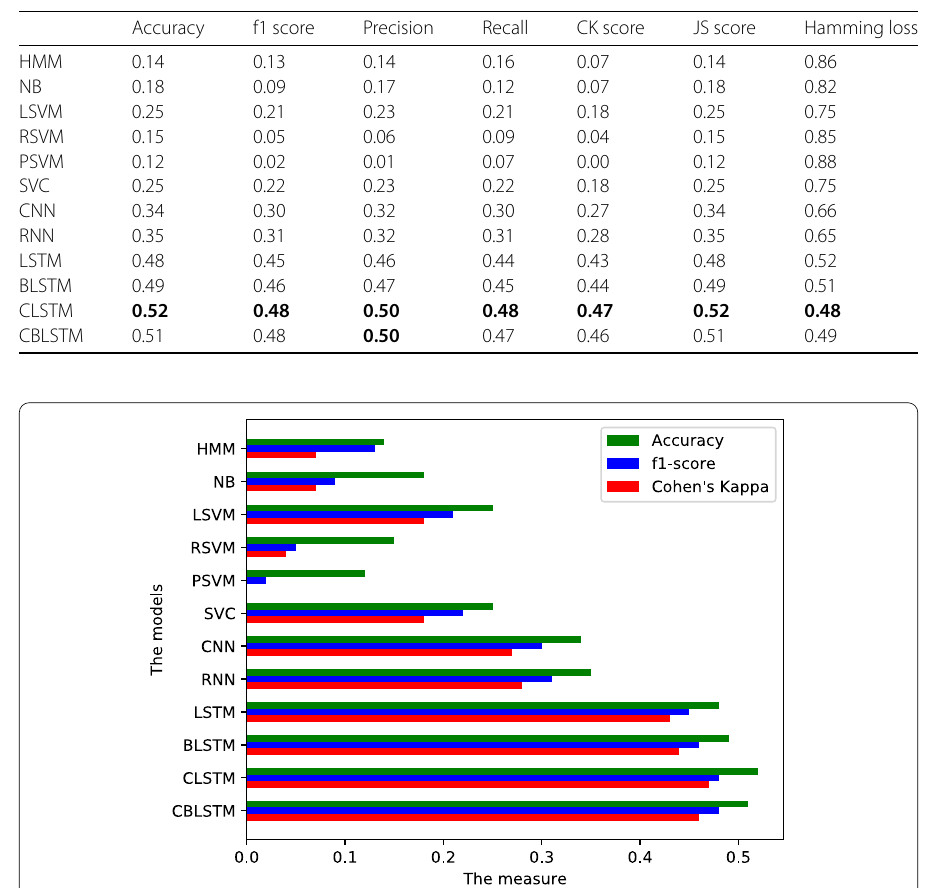
Figure 13 Performance measures over CV5. Performance measures averaged over all trajectories of all users in a CV5